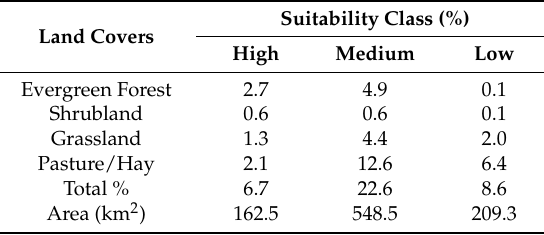
Table 5. Distribution of suitability classes under pasture/hay, grassland, shrubland, and evergreen forest.